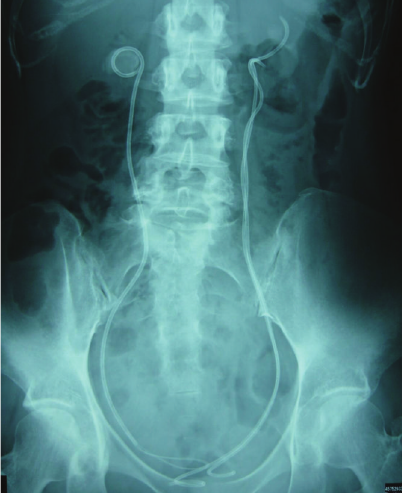
Figure 1: KUB shows bilateral renal stones. The newer stent was inserted beside the encrusted ureteral